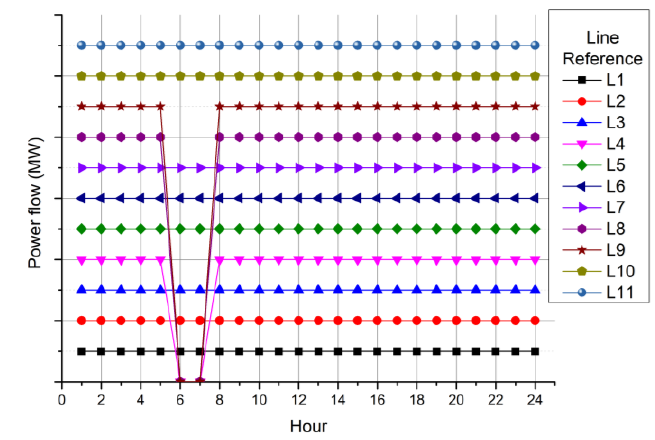
Figure 4. Simulation of the first test case. 6-bus electric power